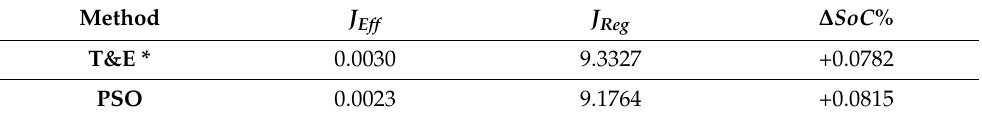
Table 2. Cost function and changes in battery charge status in different control systems.